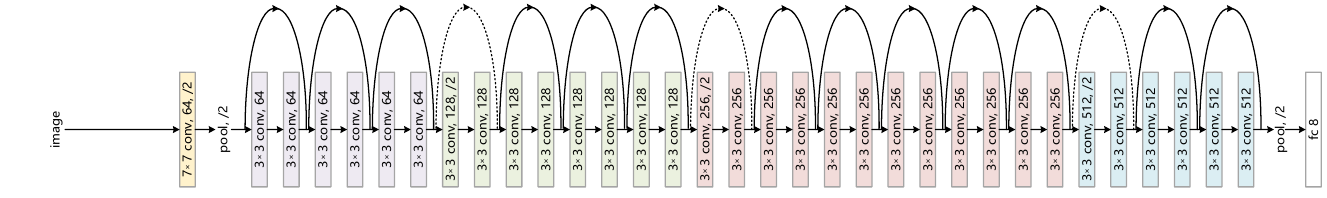
Figure 9. Image of ResNet-34 architecture.